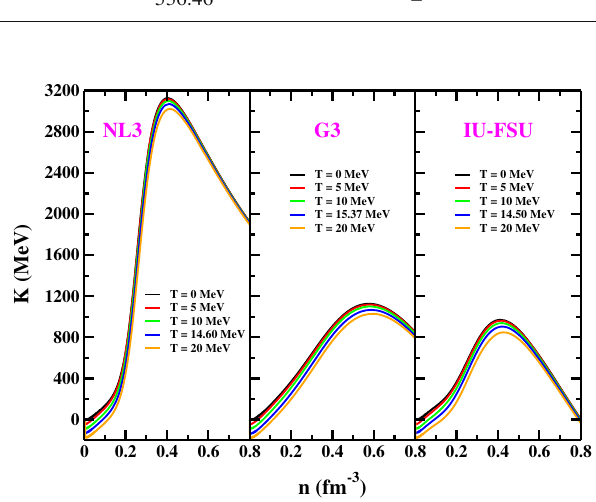
Fig. 1 Binding energy and pressure as a function of nucleon density for symmetric NM at different temperatures. The left, middle and right panels show the results for NL3, G3 and IU-FSU parameter sets respec- tively the experimental results. The effect of the temperature on free symmetry energy and its derivatives has also been stud- ied from lower to higher density of NM. Figure 4 reflects the